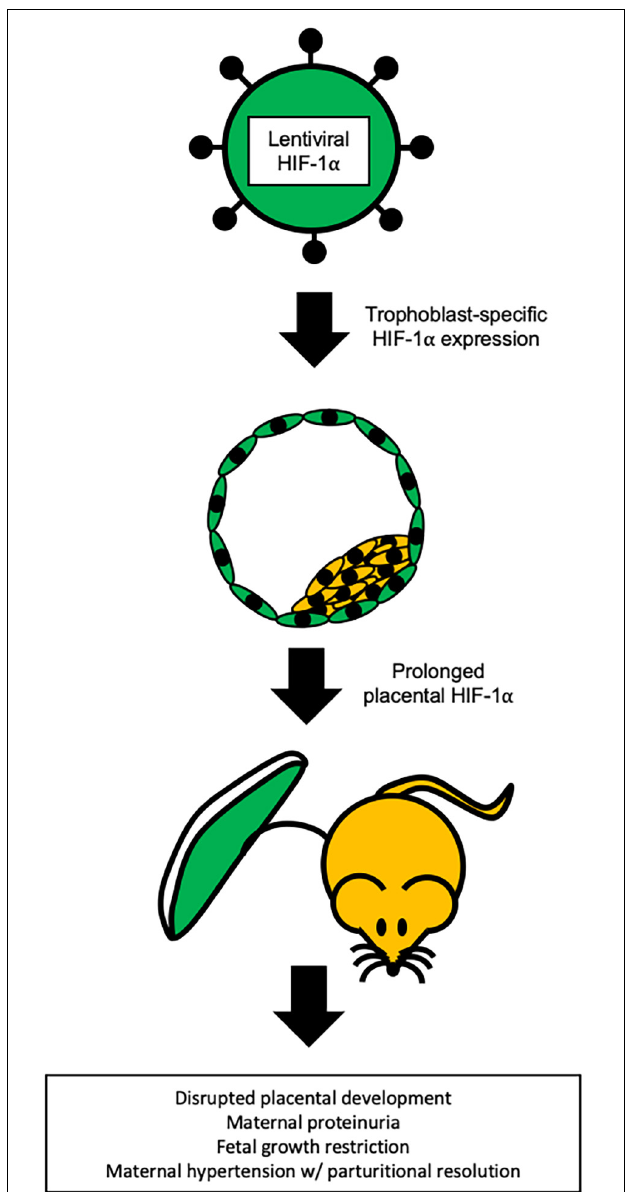
FIGURE 3 | Trophoblast specific HIF-1 α mouse model of PE. Representation of the lentiviral-mediated trophoblast-specific HIF-1 α mouse model of preeclampsia. Prolonged HIF-1 α is restricted to the trophoblasts of the placenta and results in pregnancy specific hypertension with parturitional resolution, proteinuria, and fetal growth restriction (Kaufman et al., 2014; Albers et al.,